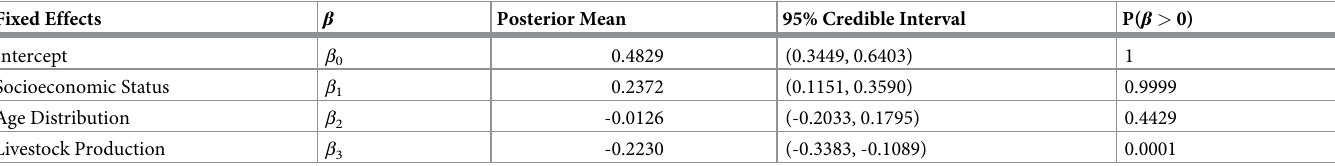
Table 2. Posterior distribution summaries for fixed effect parameters ( β